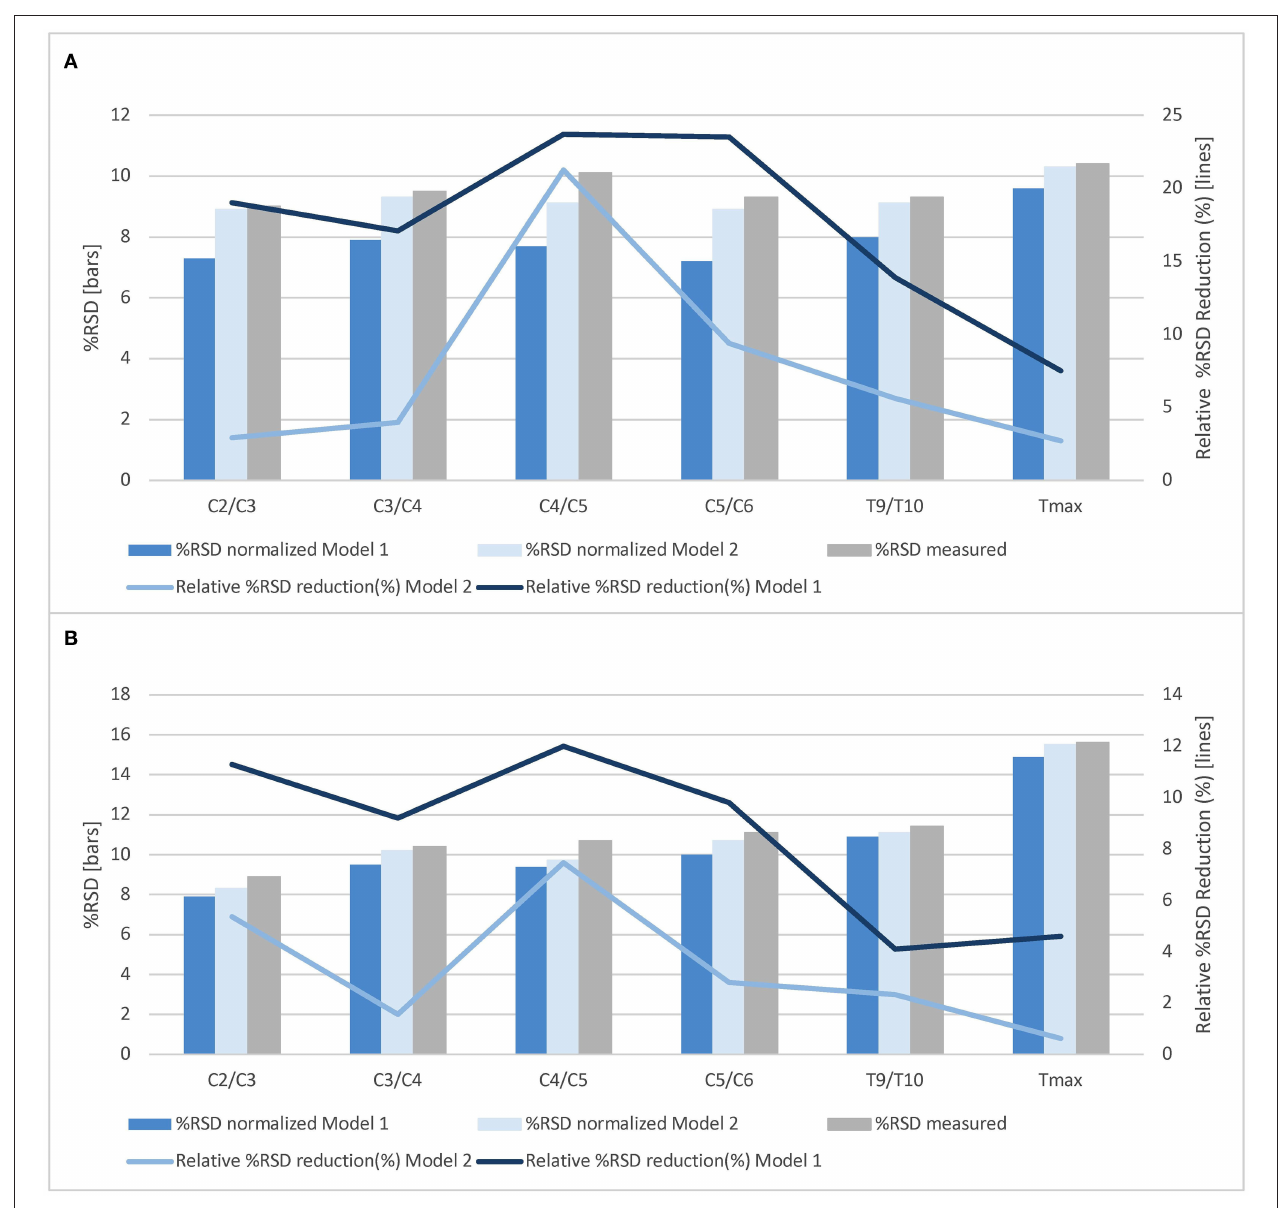
FIGURE 3 | Normalization effects of Model 1 and Model 2 on total cross-sectional cord areas and gray matter areas at all cord levels. The % relative standard deviation (RSD, standard deviation divided by the mean area) and relative % RSD reduction obtained by normalization based on Model 1 (sex, brain white matter volume and spinal canal area at the level C4/C5) as well as by Model 2 (spinal canal area at the level C4/C5) for (A) total cross-sectional cord areas and (B) spinal cord gray matter areas (whole study population, n =